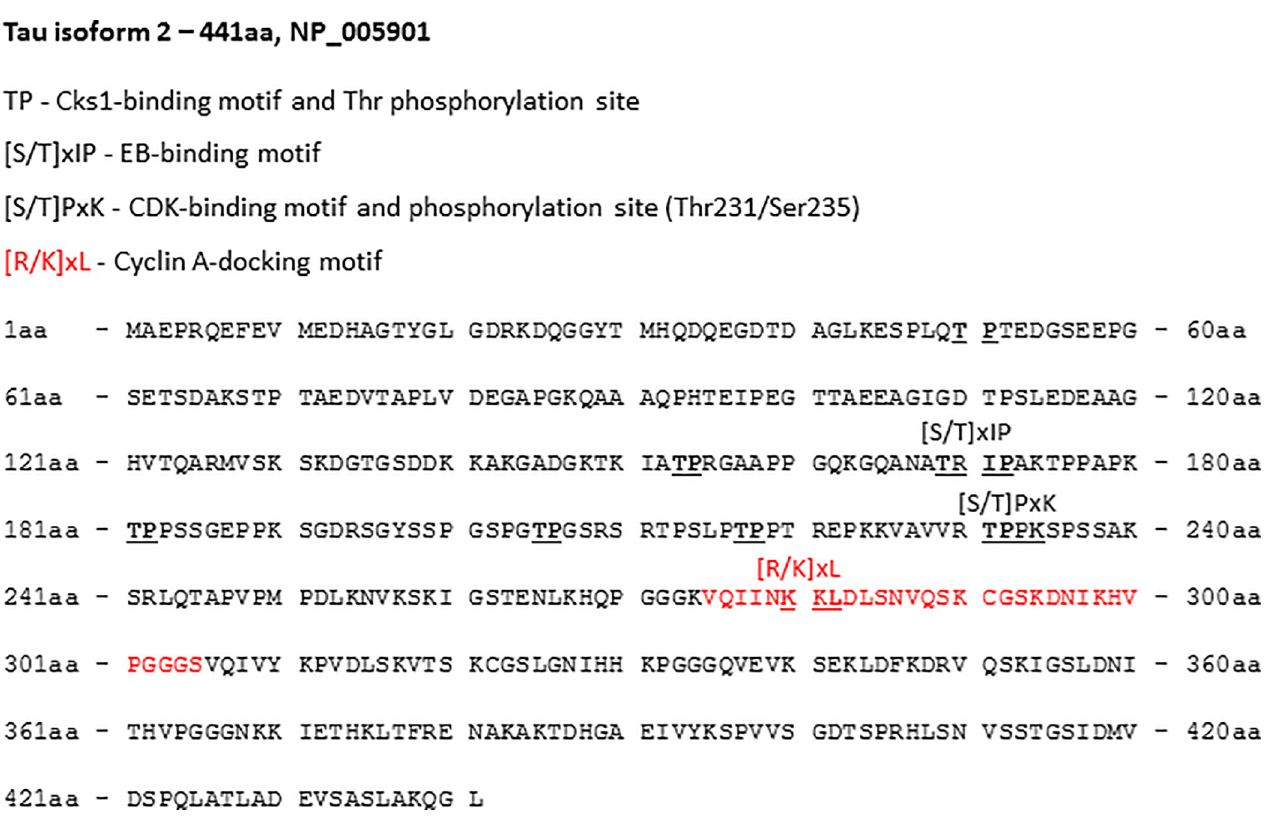
Fig 5. Amino-acid sequence of the Tau isoform 2 (NP_005901, 441aa) (Tau4R). The translated protein sequence of exon 10, which is spliced in Tau3R, is marked by red. Functional motifs, predicted by ELM analysis [30] (S1 Table and Table 1) are indicated.